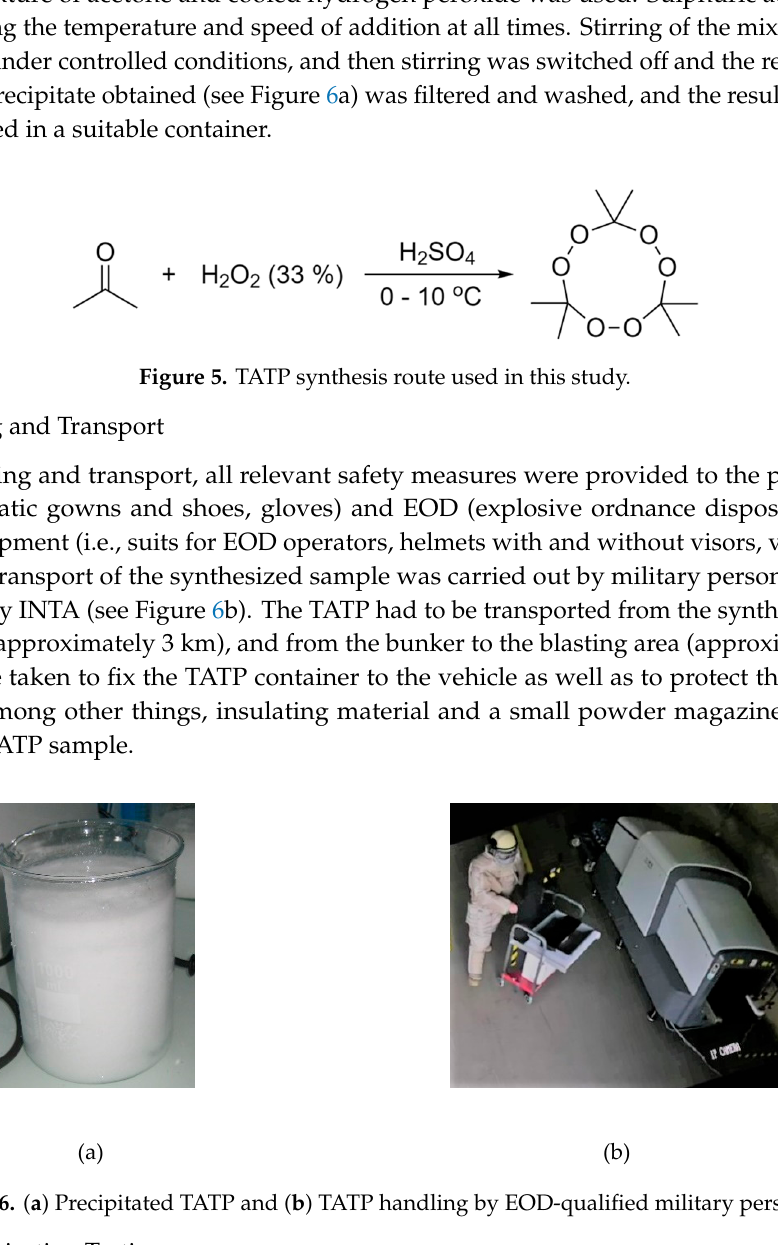
Figure 6. ( a ) Precipitated TATP and ( b ) TATP handling by EOD-qualified military